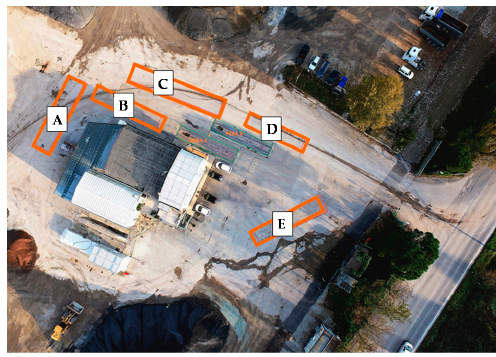
Figure 4. Location of the five Subsections.